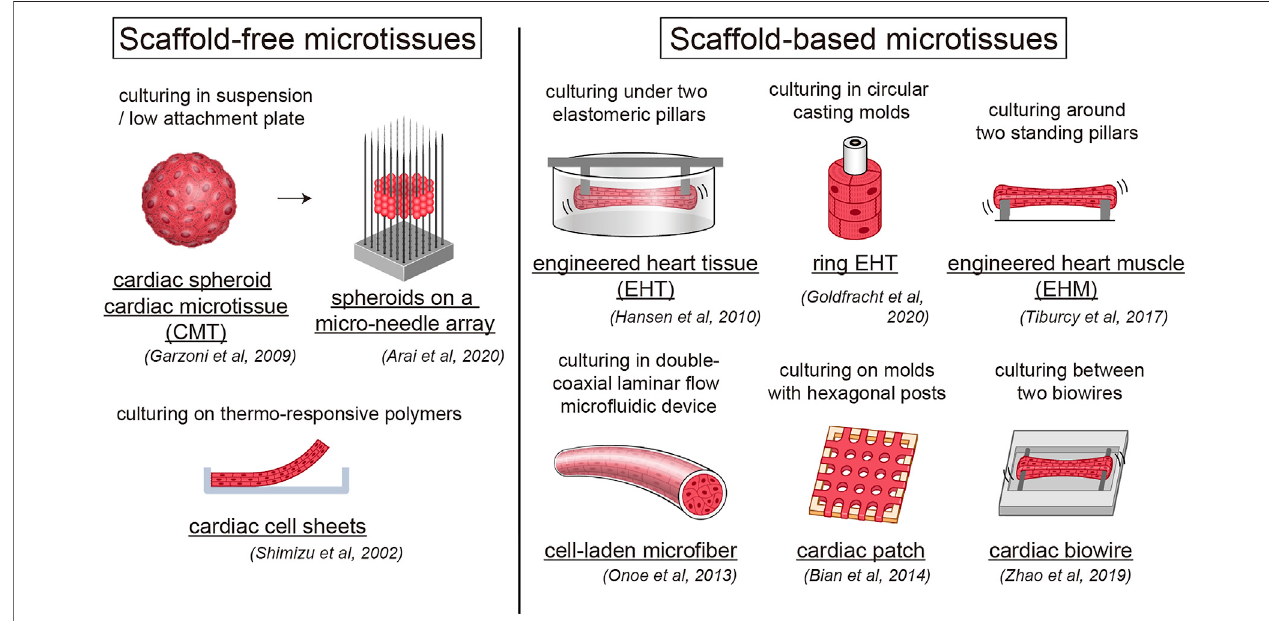
FIGURE2 | Human engineered heart tissue models with or without scaffold. Overview of scaffold-free and scaffold-based humanengineered heart tissuemodels.